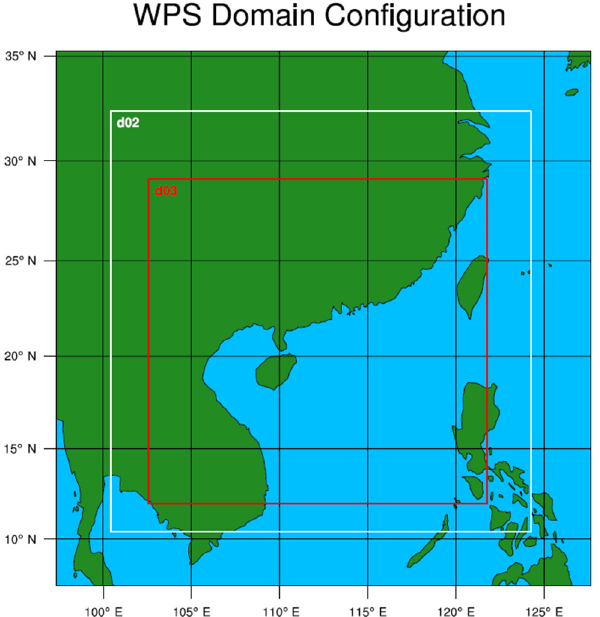
Figure 2. WRF preprocessing system (WPS) domains of this study, with the innermost domain covering entire South China Sea.